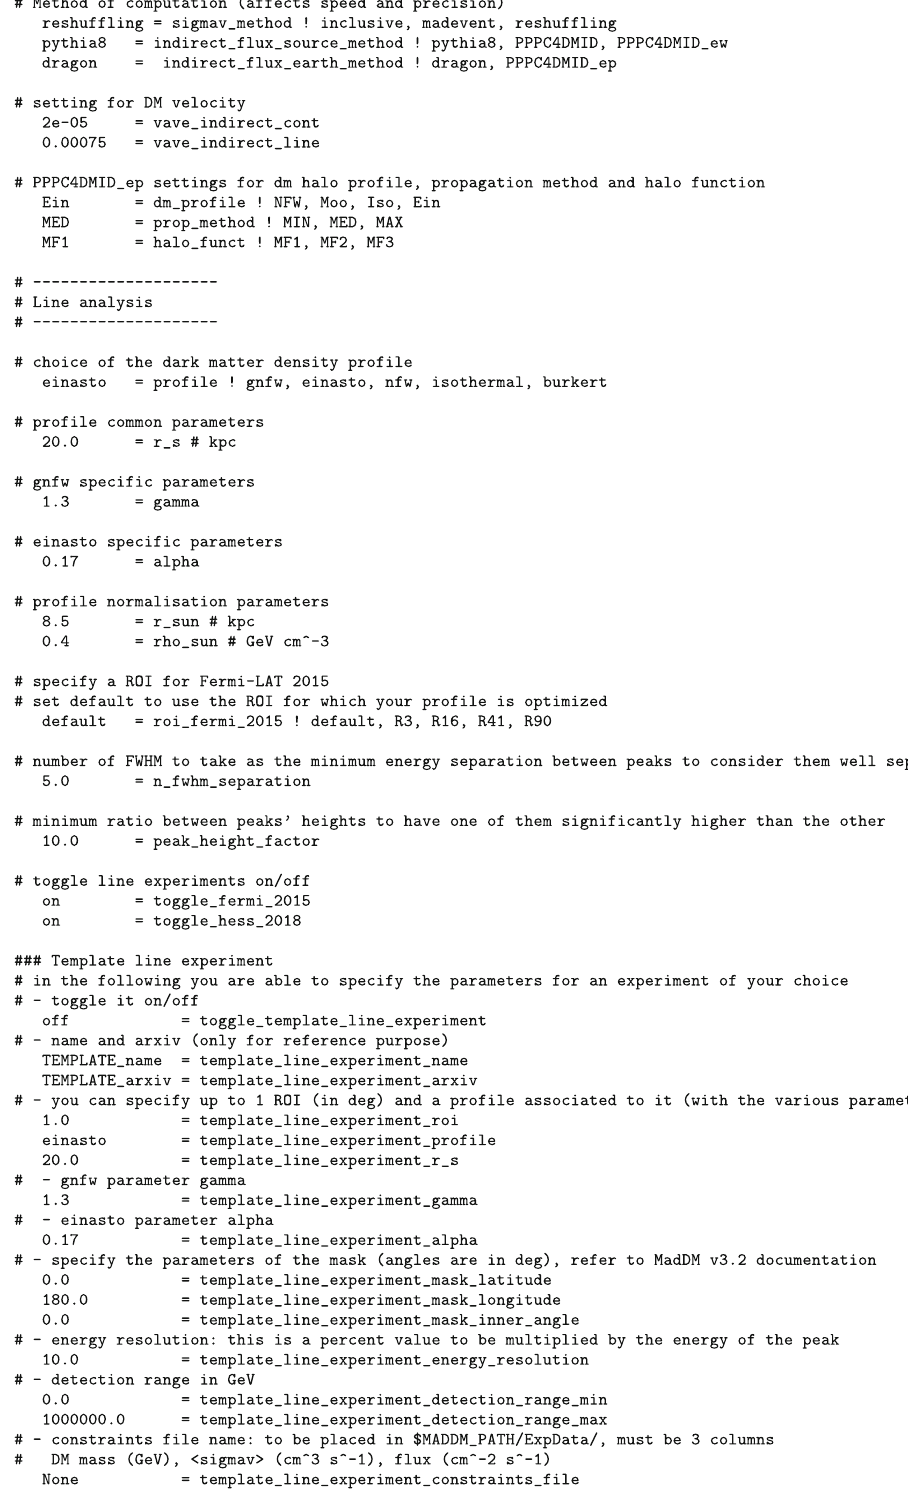
Fig. 10 Example of the content of maddm_card.dat associated with gamma-line signatures including the extended set of parameters (full